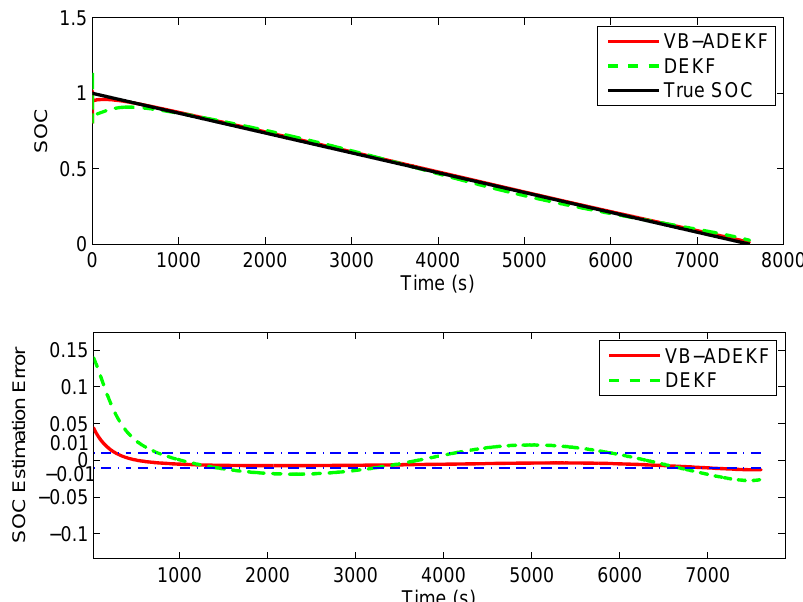
Figure 6. SOC estimation results using VB-ADEKF and dual extended Kalman filter (DEKF) in the constant current discharge test.